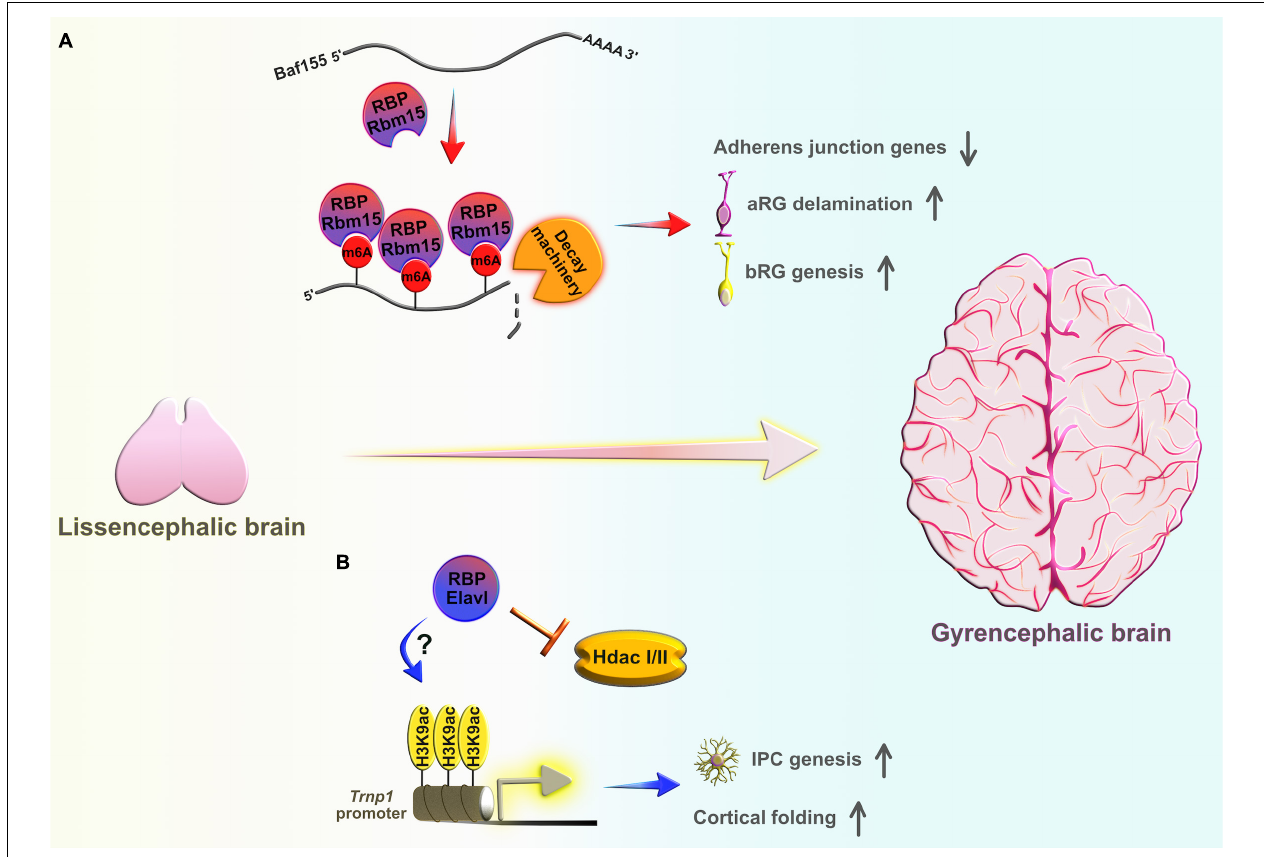
FIGURE 12 | The contribution of RNA-binding proteins (RBPs) to the production of basal progenitors and expansion of the neocortex. (A) RBP Rbm15 regulates epitranscriptomically the expression of the chromatin remodeler Baf155 , which in turn controls the expression programs of genes encoding AJ proteins. As a part of the N 6 -methyladenosine (m 6 A) methyltransferase complex, Rbm15 initiates the addition m 6 A modification Baf155 mRNA, and governs its decay through the mRNA methylation machinery. The downstream effect of the reduced BAF155 mRNA stability causes downregulation of AJ proteins at the ventricular surface, supporting the generation of basal radial glia (bRG), initially dependent on apical radial glia (aRG) delamination during early stages of neocortical development. (B) At later stages of neocortical development, another epigenetic mechanism, H3 lysine 9 acetylation (H3K9ac), drives the expansion of the neocortex by regulating the expression of regulatory factors (e.g., Trnp1 ) which are, in turn, responsible for the incremental basal progenitors’ self-renewal capacity. As such, inhibition of class I/II histone deacetylases (Hdac I/II), and/or H3K9ac epigenome editing of Trnp1 promoter was sufficient to promote the genesis of intermediate progenitor cells (IPC) and evoke cortical folding in mice. Elavl family members can block Hdac II activity. These RBPs may act as upstream regulators of local histone hyperacetylation, boosting neuronal output and inducing gyrification during neocortical